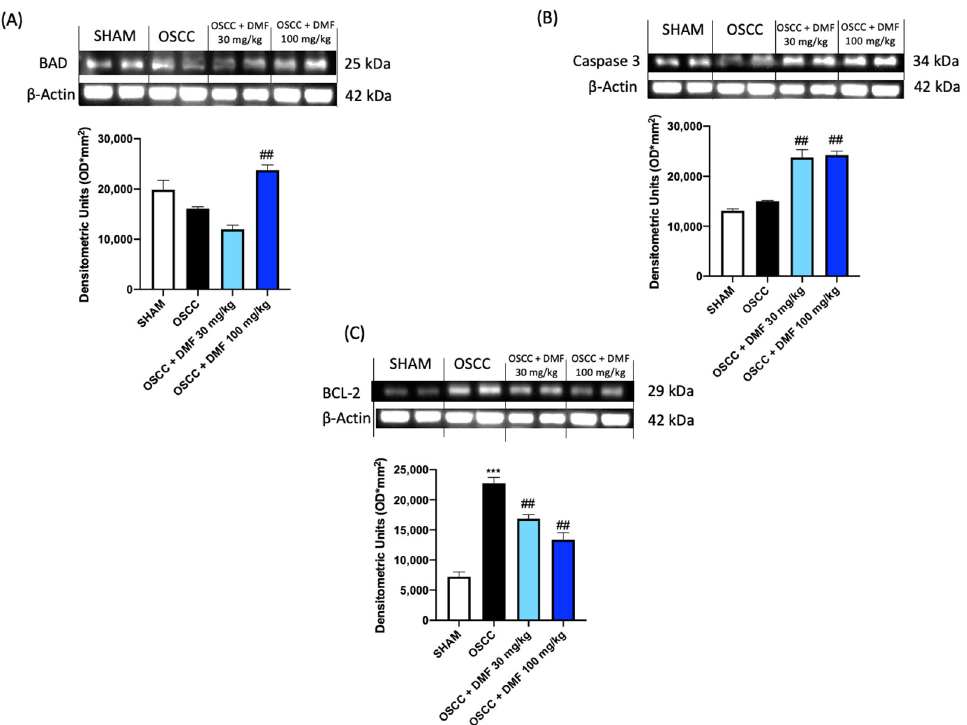
Figure 8. Effect of DMF on Caspase3, BAD and BCL-2 expression in tongue samples ( A – C ). The blots revealed an increase of pro-apoptotic BAD expression after DMF treatment especially at the dose of 100 mg/kg and Caspase 3 at both doses. A decrease of anti-apoptotic BCL-2 expression followed DMF treatment in a dose dependent manner compared to OSCC group. Data are representative of at least three independent experiments. ( A , B ) ## p < 0.01 vs. OSCC; ( C ) *** p < 0.001 vs. SHAM; ## p < 0.01 vs. OSCC.